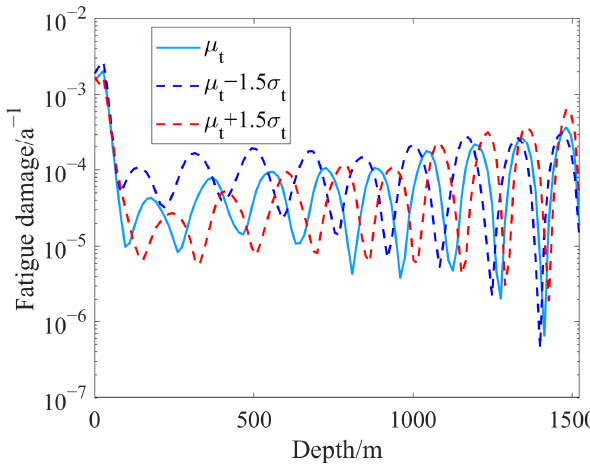
Figure 8. Effect of t on fatigue damage.